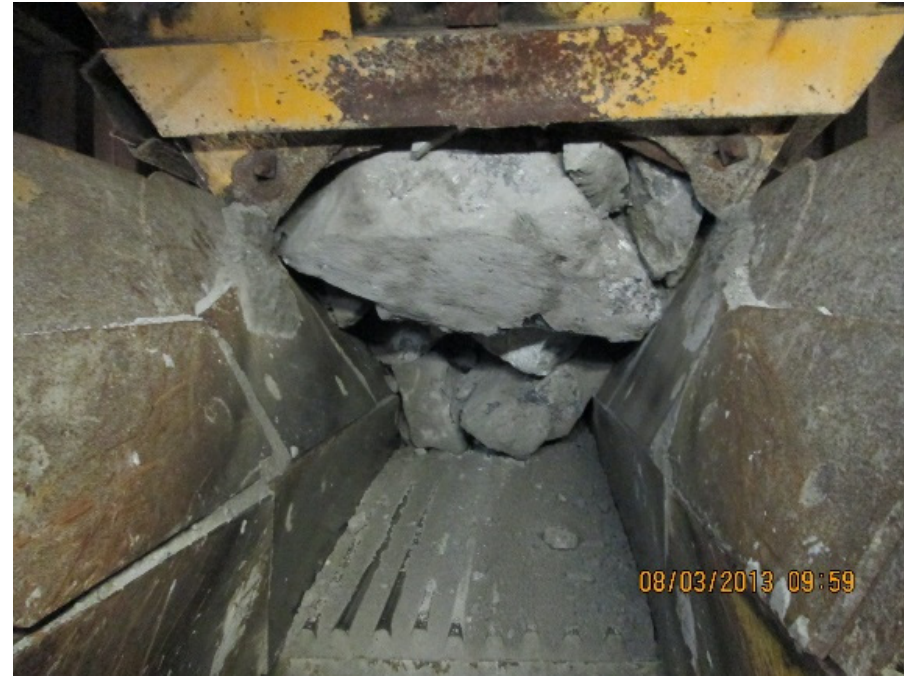
Figure 3. Blockage in the feeder carriage.